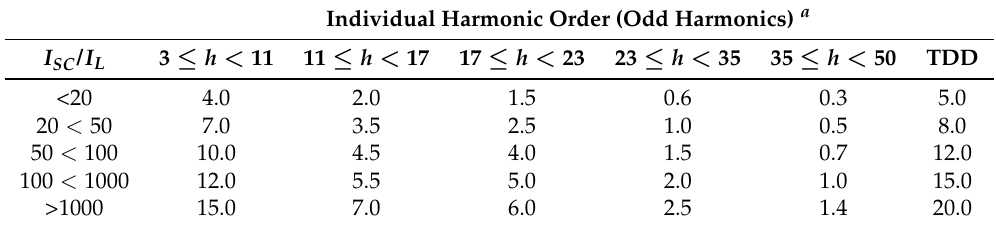
Table 6. Maximum harmonic current distortion in percent of I L [10].